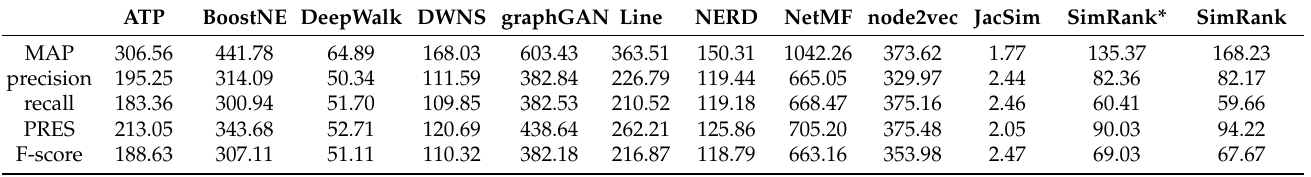
Table 9. Accuracy improvements (%) by JPRank over other methods with the DBLP dataset.